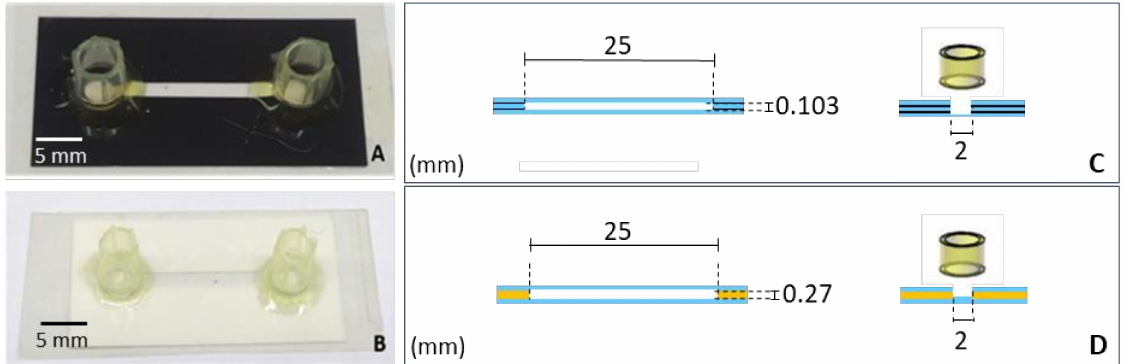
Figure 4. Laminated microchips. ( A , C ): Photography of PET microchip and its frontal and transversal section dimensions, respectively. ( B , D ): Photograph of vinyl adhesive microchip and its frontal and transversal section dimensions, respectively. The blue layer is polyester films, the black is the toner and the yellow is the vinyl